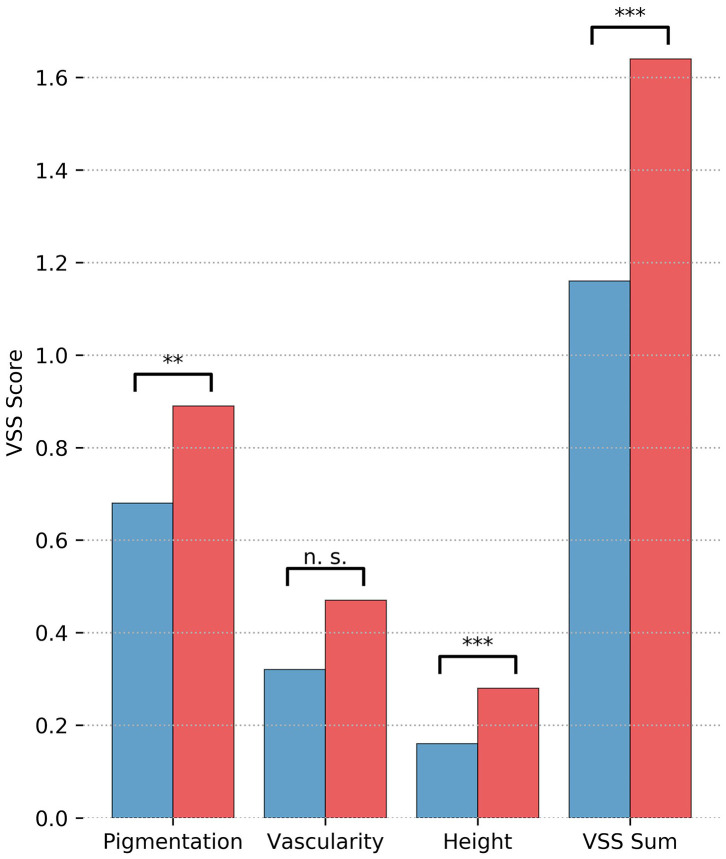
Results of the online evaluation of 230 scars by independent surgeons for mean modified Vancouver Scar Scale Scores are illustrated separately by treatment group (blue = group 1, tissue adhesive, red = group 2, suture). Significance levels are indicated. Significance levels are indicated (**p < 0.01, ***p < 0.001).